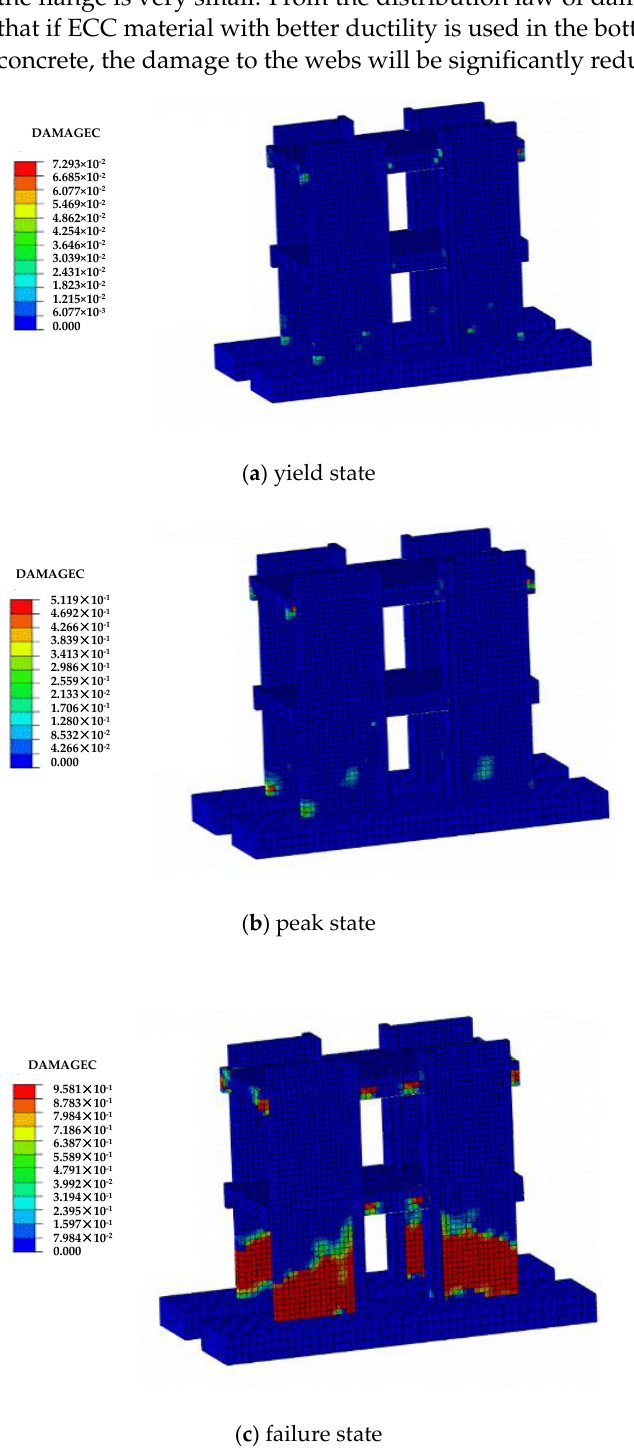
Figure 13. Compressive damage distribution of the prefabricated ECC/RC combined shear wall.